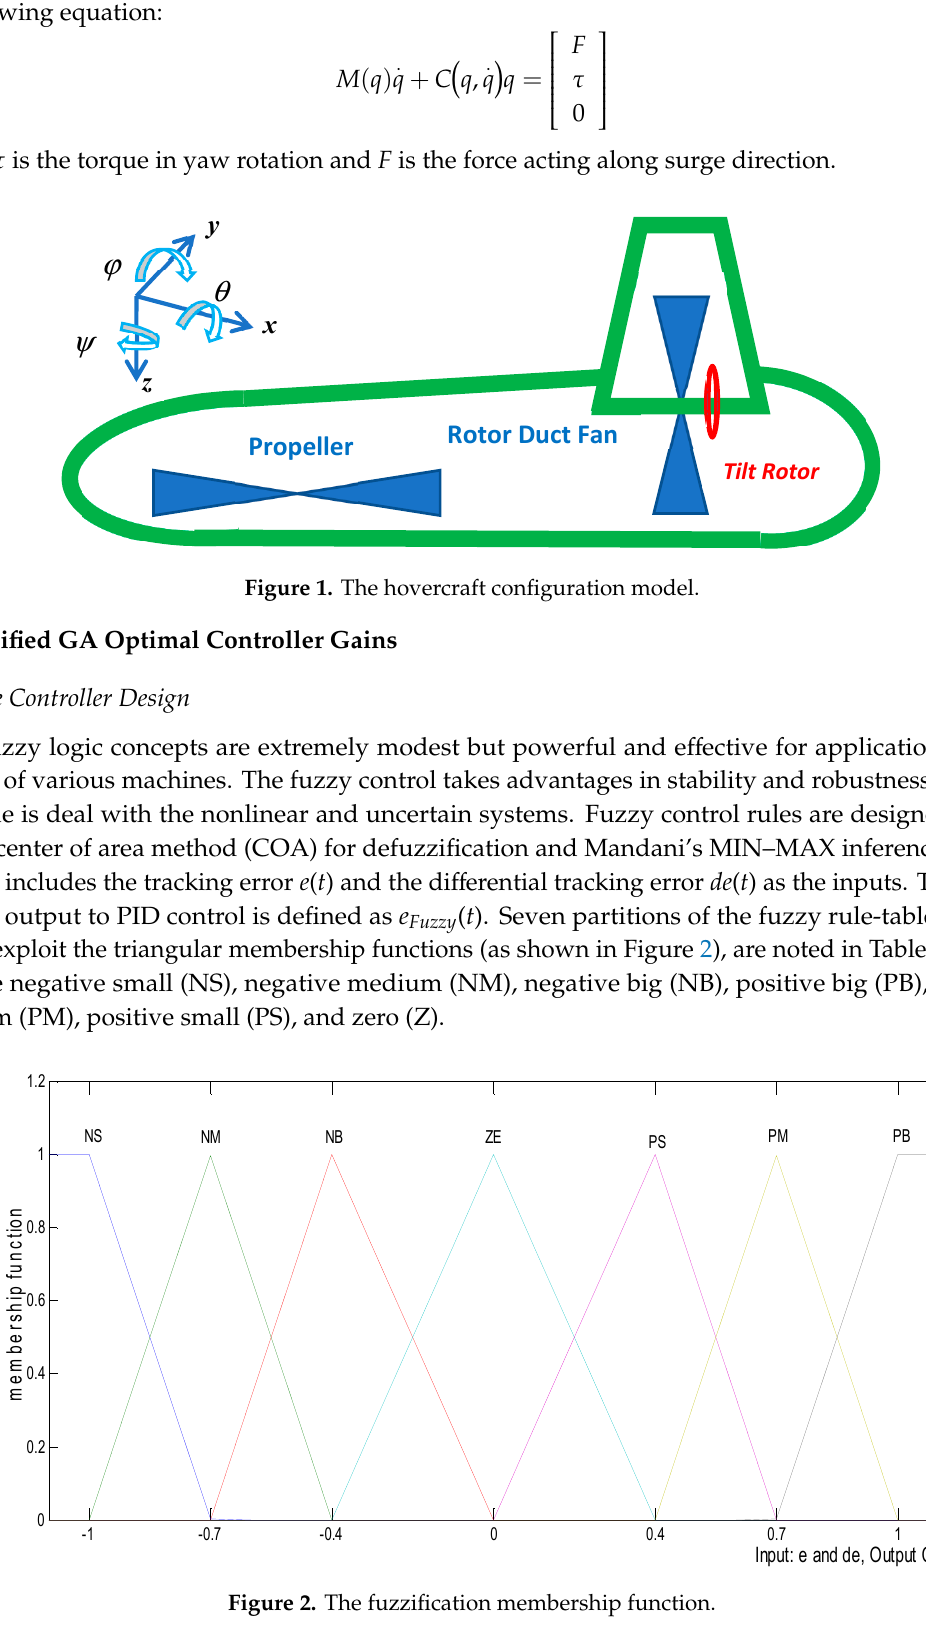
Figure 3. The controller block diagram. 3.2. Improved GA in the Optimization Process The standard GA’s characteristics [3], which includes three main parameters—mutation rate ( Rm ), crossover rate ( Rc ), and population size ( N )—were employed to verify the optimized gains of